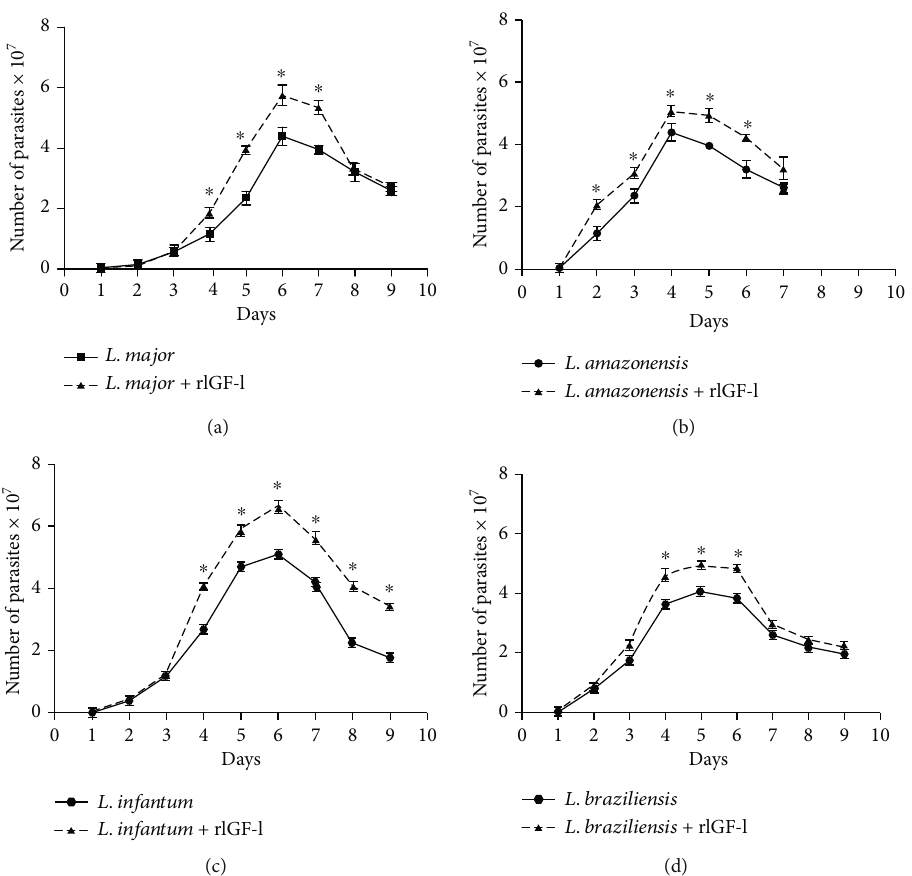
Figure 1: Growth curves of Leishmania spp promastigotes upon IGF-I stimulus. L. major , L. amazonensis , L. infantum , and L. braziliensis promastigotes ( 5 × 10 5 /mL) were cultured in 199 medium (Cultilab, Brazil) and Schneider ’ s Insect medium (Sigma-Aldrich, USA), respectively, supplemented with 5% heat-inactivated fetal calf serum (FCS) (Cultilab, Brazil) at 26 ° C, with or without 50ng/mL IGF-I (rIGF-I, R&D Systems, USA). The growth of parasites was monitored by daily counting, for 10 days, in a Neubauer chamber, and the results are presented as the number of parasites × 10 7 /mL ( mean ± standarddeviation ) from three independent cultures with or without 50ng/mL IGF-I. ∗ p < 0 : 05 (one-way ANOVA) compared with the culture without IGF-I (adapted from Reis et al.